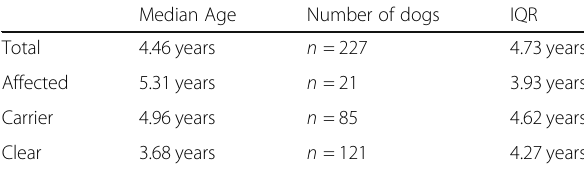
Table 2 Age of PBGV, with comparison between genotypes